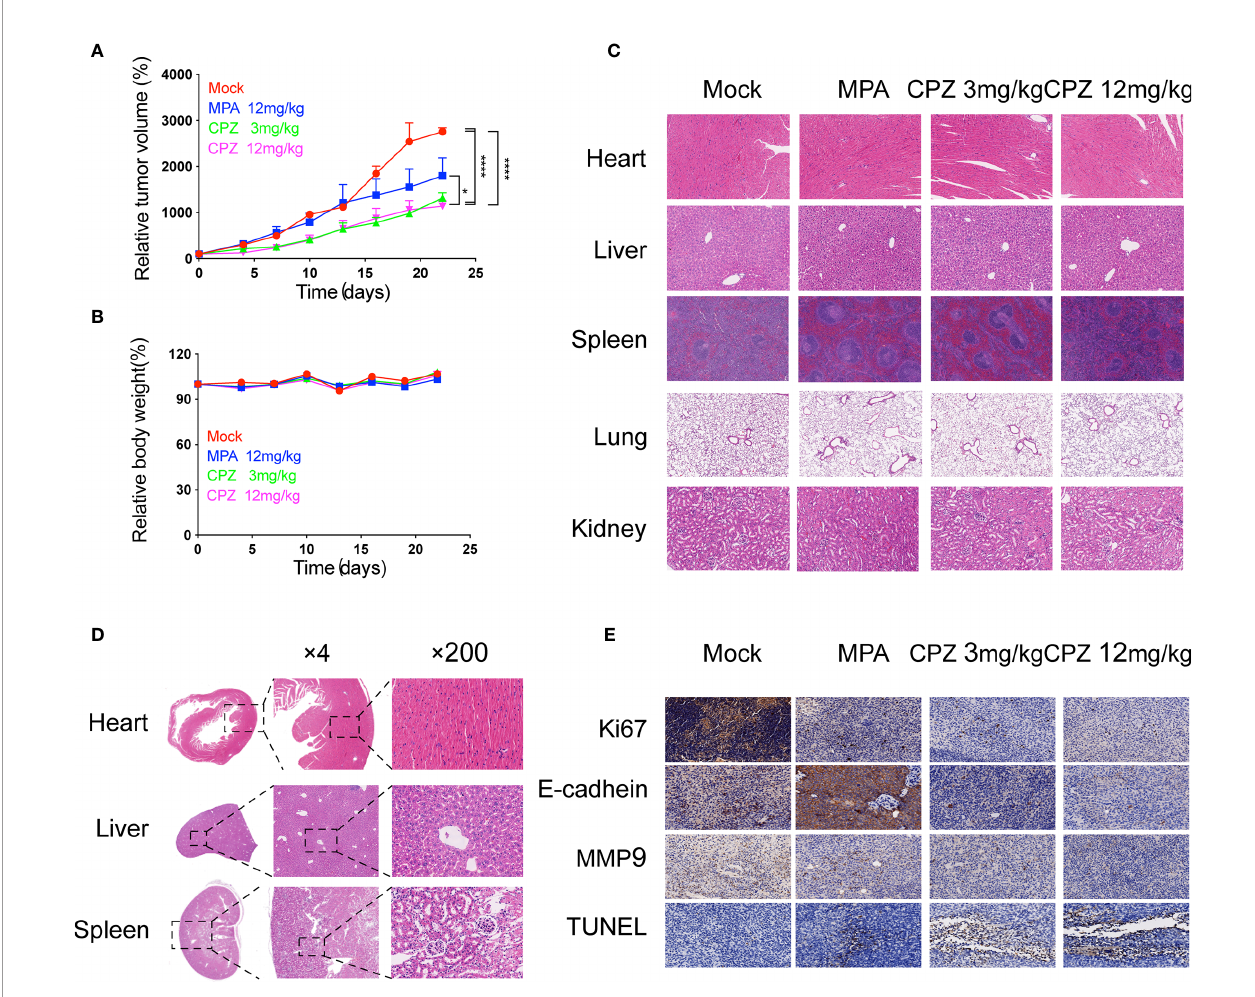
FIGURE 2 | Antitumor ef fi cacy and toxicity assessment of CPZ in ISK xenograft model. (A) Tumour size and (B) body weight measurements from ISK xenograft mice after CPZ. We set the initial body weight and tumor size to 100%. (C) CPZ treatment did not have a toxic effect on any of the fi ve major organs. (D) H&E- stained sections of heart, liver, and kidney from a mouse treated with CPZ (12mg/kg) revealed that the tissue and cell architecture were both normal. The area of tissue marked by the dotted square is shown at a higher magni fi cation in the right panel (E) Immunohistochemical staining assay. (*p < 0.05, ****p < 0.0001, two-way analysis of variance with Tukey ’ s multiple comparisons test). Data expressed as mean ± standard error of the mean.